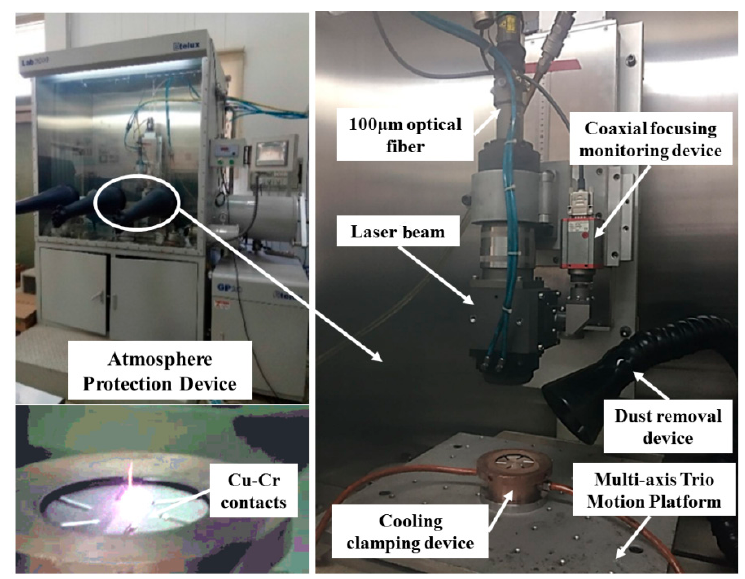
Figure 2. Schematic diagram of laser surface melting process for Cu-50Cr (wt%) alloy.